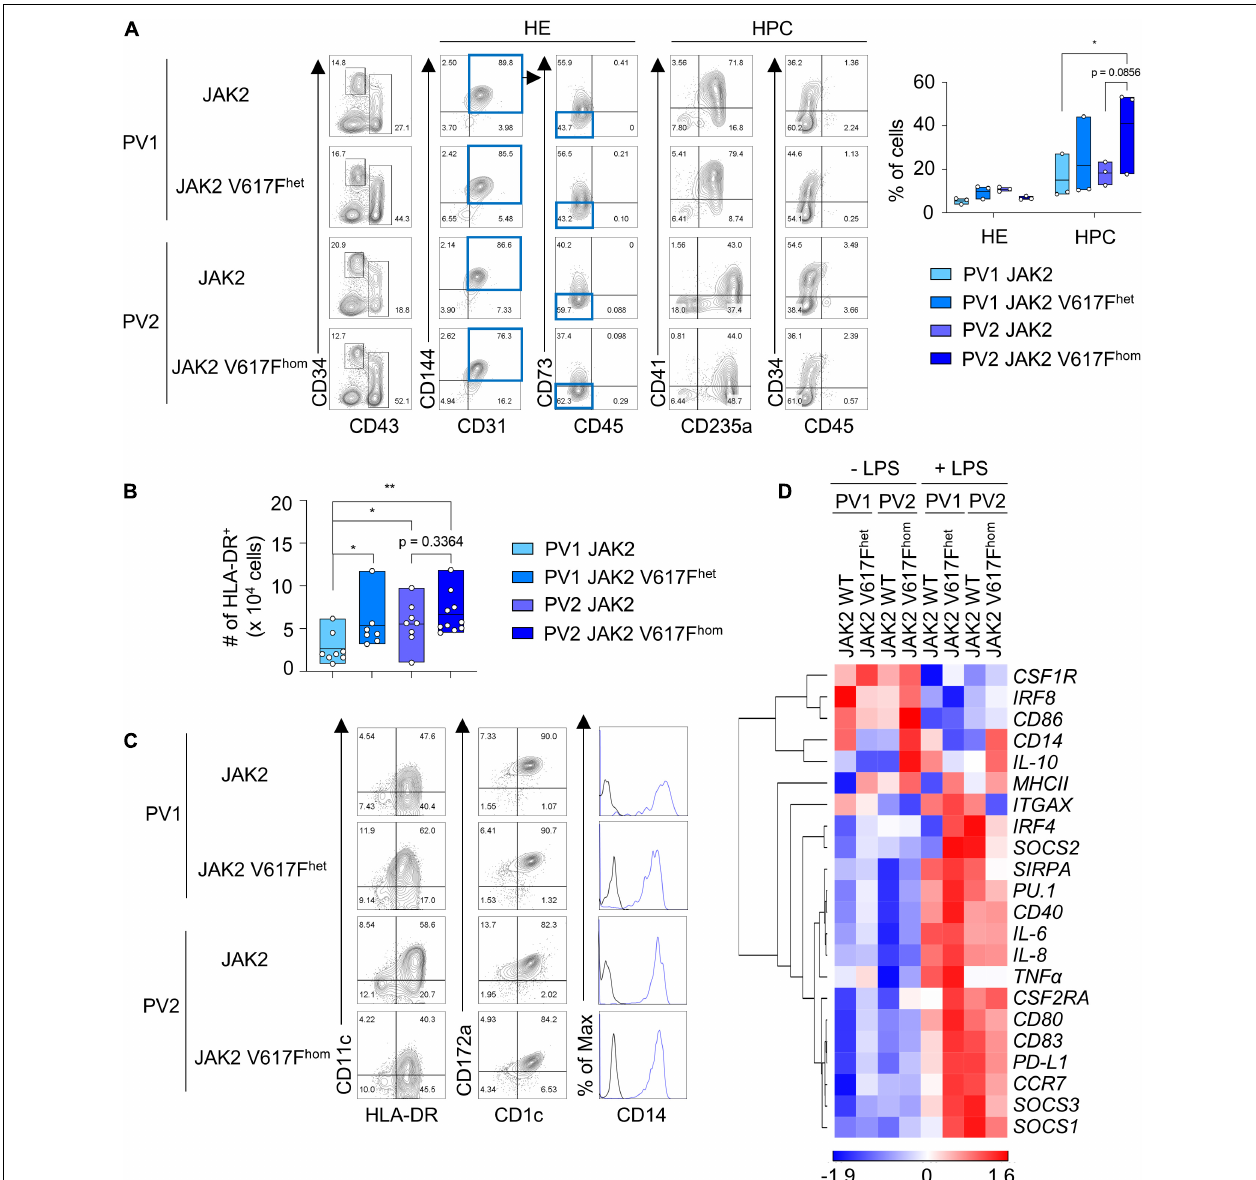
FIGURE 2 | JAK2 V617F het and JAK2 V617F hom iPS cells differentiate into DC. (A) Representative flow cytometry analysis and quantification of HE and HPC (CD34 + CD31 + CD144 + CD43 − CD45 − CD73 − cells and CD43 + CD34 low / − cells, respectively) in EB on day 10 of spin EB differentiation. JAK2 V617F het and JAK2 V617F hom om cells of PV patient 1 (PV1) and PV patient 2 (PV2), respectively, and cells of PV1 and PV2 without JAK2 V617F mutation (JAK2) are shown. n = 3, line represents mean; * p < 0.05, two-way ANOVA with Tukey’s multiple comparisons test. (B) The number of HLA-DR + cells on day 8–9 of DC differentiation. JAK2 genotypes are as in (A) . n = 7–10, line represents mean; * p < 0.05, ** p < 0.005, one-way ANOVA with uncorrected fisher’s LSD test. (C) Expression of the DC markers CD1c, CD11c, and CD172a, and of CD14 on HLA-DR + cells was assessed by flow cytometry. Blue lines and black lines in histograms show stained and unstained cells, respectively. (D) Gene expression profiling of unstimulated and LPS-stimulated CD1c + HLA-DR + cells on day 8–9 + 1 of DC differentiation by RT-qPCR analysis. Expression values were normalized to GAPDH and z-scores of − (cid:49) Ct mean calculated for each gene are shown in heat map format as in Figure 1E . n =